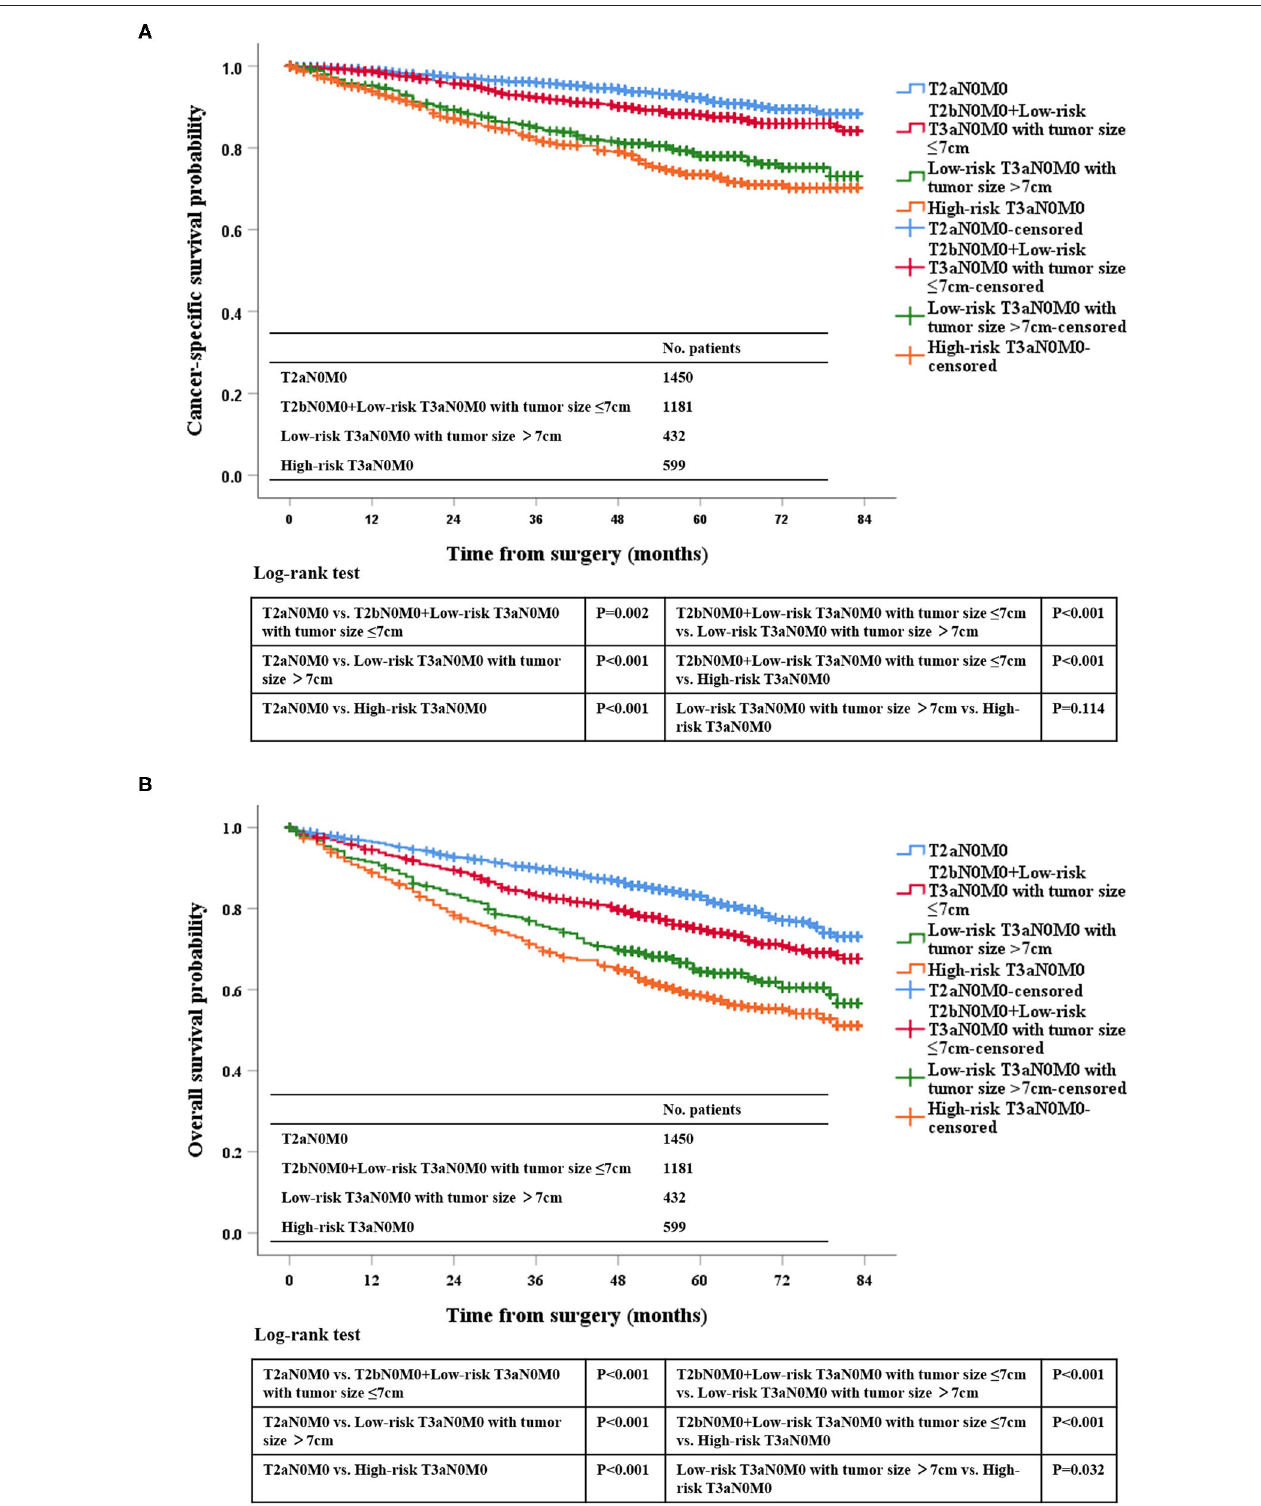
FIGURE 3 | Kaplan-Meier survival estimates for pT2aN0M0, pT2bN0M0 and low-risk pT3aN0M0 RCC patients with tumor size ≤ 7cm, low-risk pT3aN0M0 patients with tumor size of > 7cm, and high-risk pT3aN0M0 patients who underwent radical surgery for CSS (A) and OS (B) .